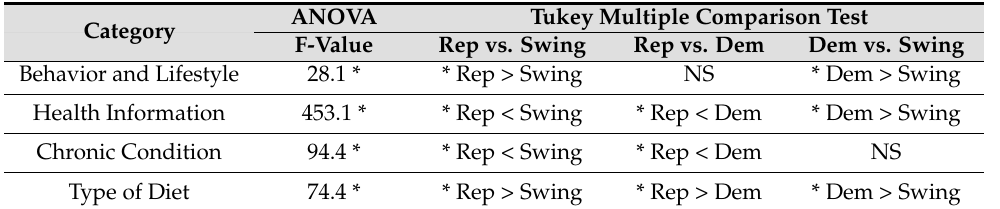
Table 6. Comparison of democratic (Dem), republican (Rep), and swing states. Not Significant